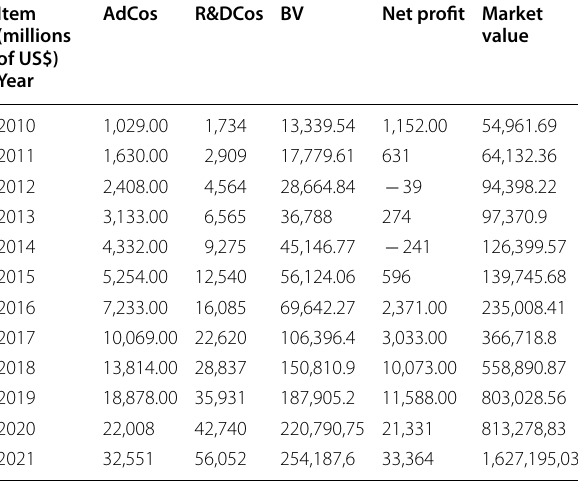
Table 6 Amazon.com, Inc. data. Source: Amazon.com, Inc Item (millions of US$)